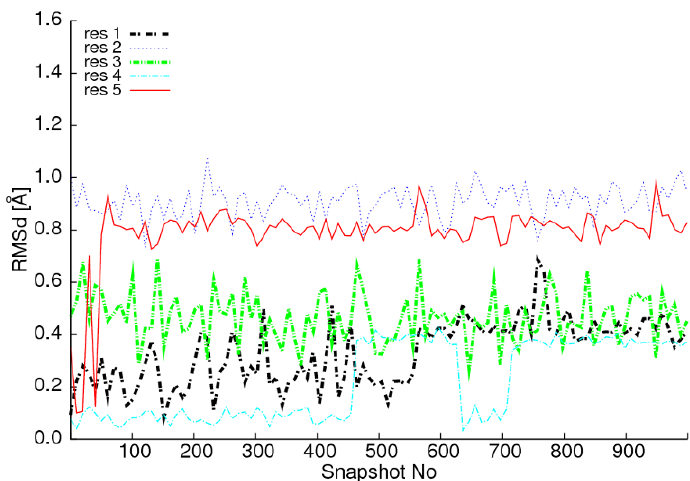
Figure 4. Plot of RMSd changes of DA-DSer during unconstrained